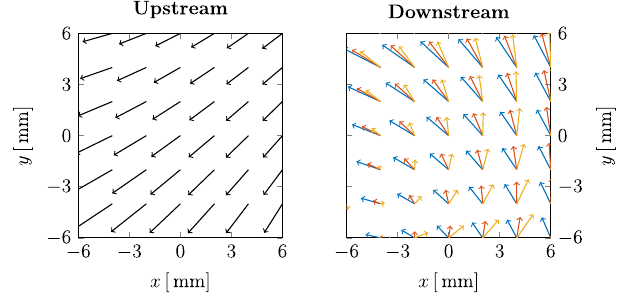
FIG. 4. Real part of the normalized complex kick factor for the upstream (left) and downstream couplers (right) as a function of the transverse coordinates x and y . All vectors are scaled by the same amount in order to assure a quantitative comparison. The three colors in the right correspond to the case of pure filling (blue) of the cavity, e.g., no reflected wave and Γ ¼ − 1 , standing- wave operation (red, Γ ¼ 0 ) and pure decay mode (yellow, Γ ¼ 1 ), where there is no incoming wave. Note that the kick induced by the downstream HOM coupler does not change for different Γ . The net effect of the power coupler is primarily